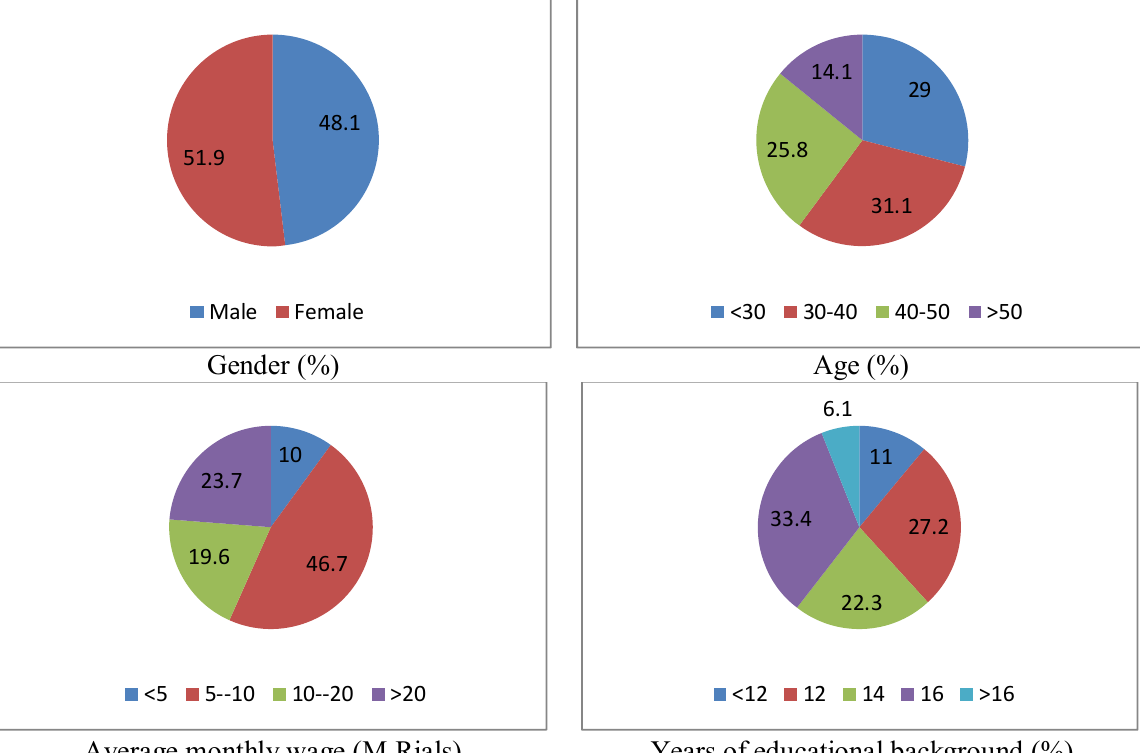
Fig. 2. Personal characteristics of the